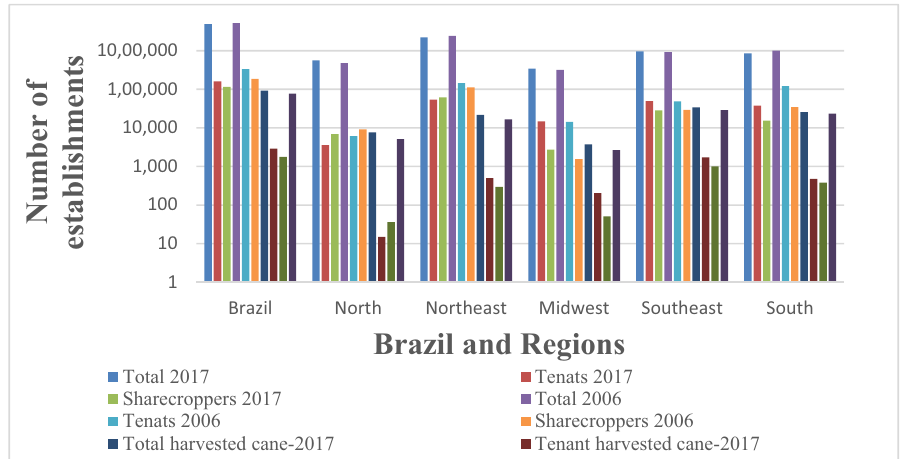
Figure 2: Comparison of numbers of establishments 2017/2006 and the total harvested establishments of sugarcane in 2017 according to the condition of the producers for Brazil and regions. Source: Own elaboration from ref. [ 47 ] .